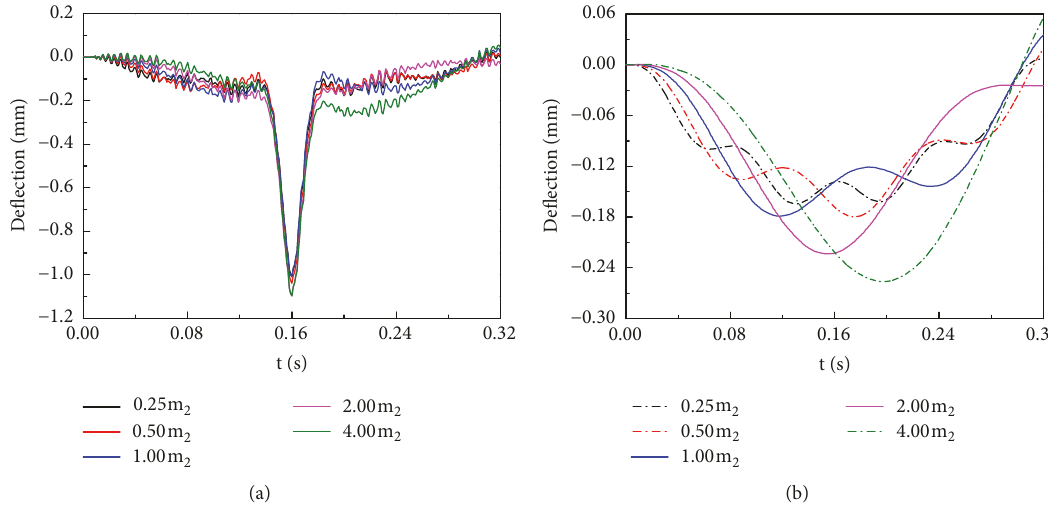
Figure 14: Comparison diagram of mid-span deflection time-history for double simply supported rail-bridge system under different masses of second beam: (a) first beam; (b) second beam.